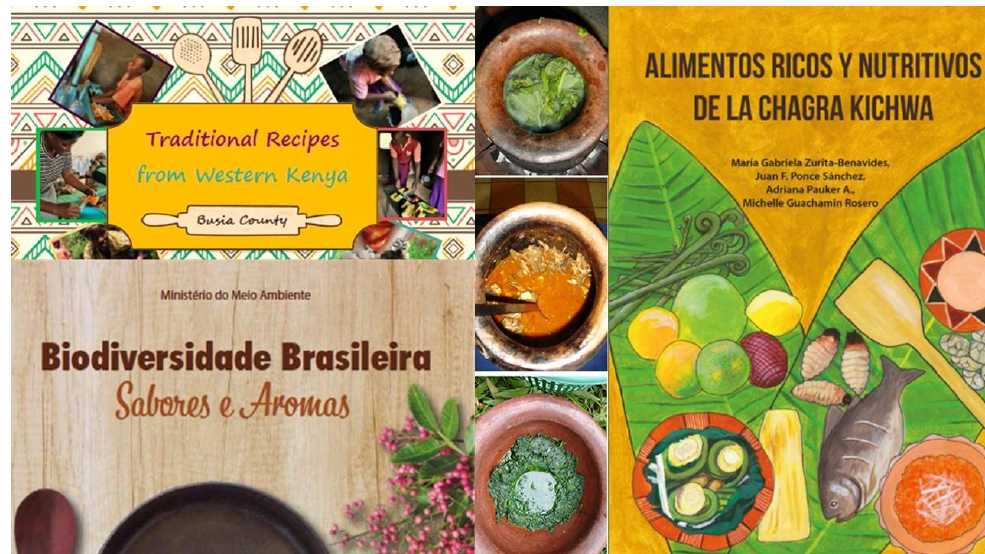
Figure 10. Front covers of recipe books developed as part of the WFP-focused projects in Brazil, Ecuador and Kenya. Credit: BFN Brazil, IKIAM and BFN Kenya.